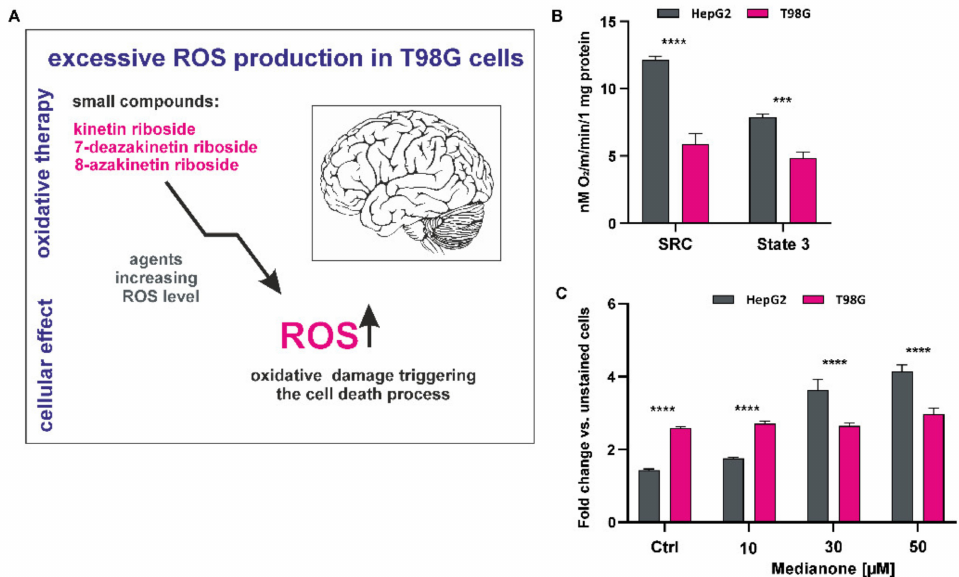
Figure 1. Aerobic status of glioblastoma (T98G) and non-glioblastoma (HepG2) cells. ( A ) Involve- ment of small compounds in the oxidative therapy of T98G cells. ( B ) Comparison of spare respiration capacity (SRC) and phosphorylating state (state 3) of T98G cells (gray) vs. HepG2 cells (magenta) by using the Oxygraph+ system. ( C ) Flow cytometry analysis of comparative mitochondrial oxidative stress induction in T98G cells (gray) and HepG2 cells (magenta) after menadione treatment. Fluo- rescence intensity shift is presented as a bar graph (mean ± SD) of three independent